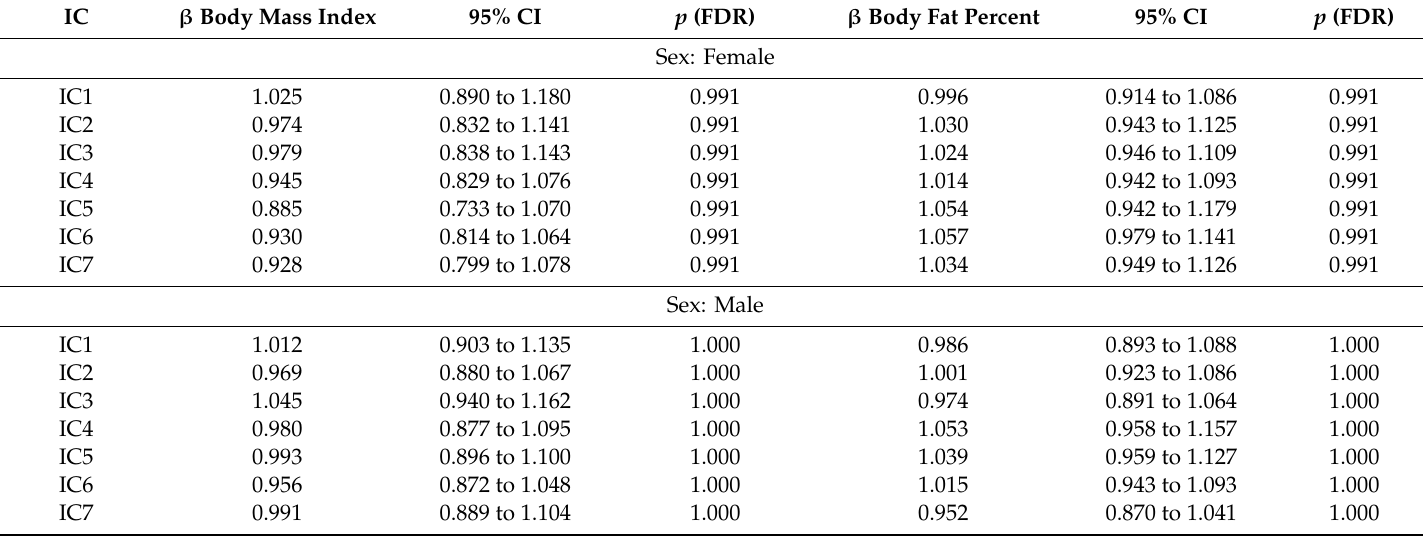
Table A2. Regression Coe ffi cients for the ICs and body